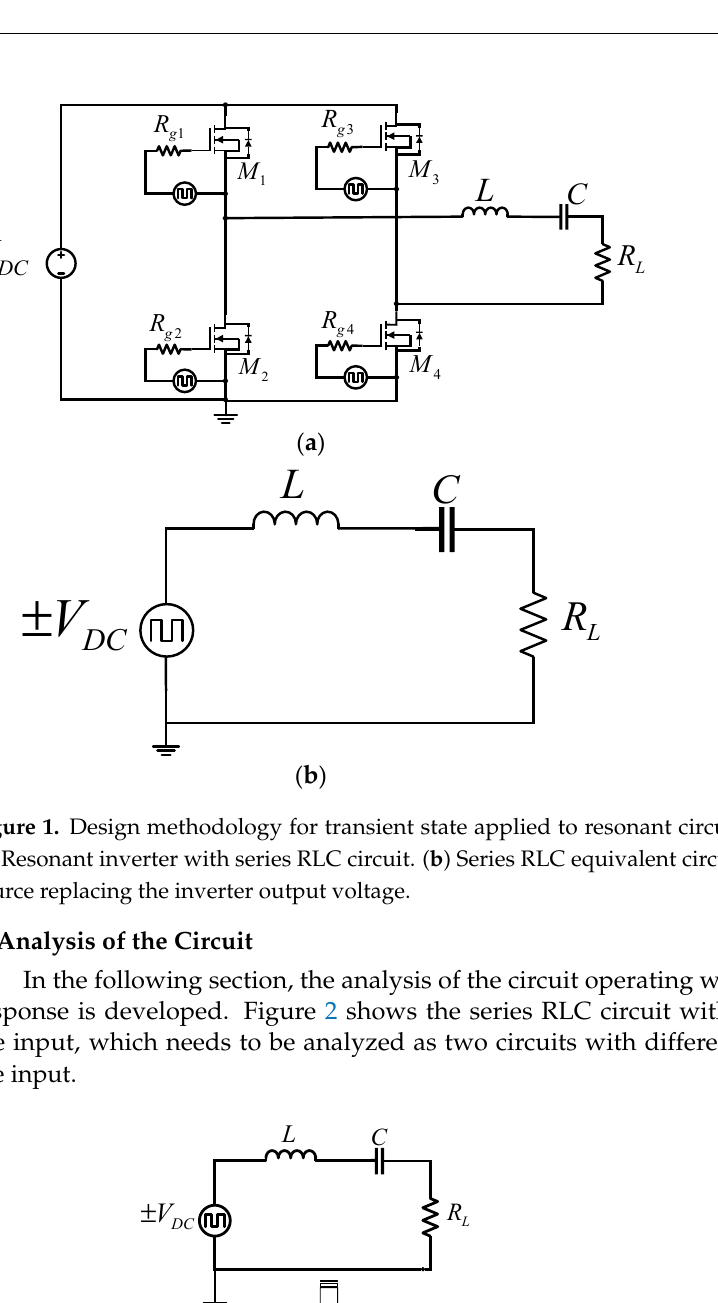
Figure 2. Series RLC resonant circuit with bipolar square voltage source at the input. ( a ) Series RLC circuit when the voltage source is positive. ( b ) Series RLC circuit when the voltage source is nega- tive.